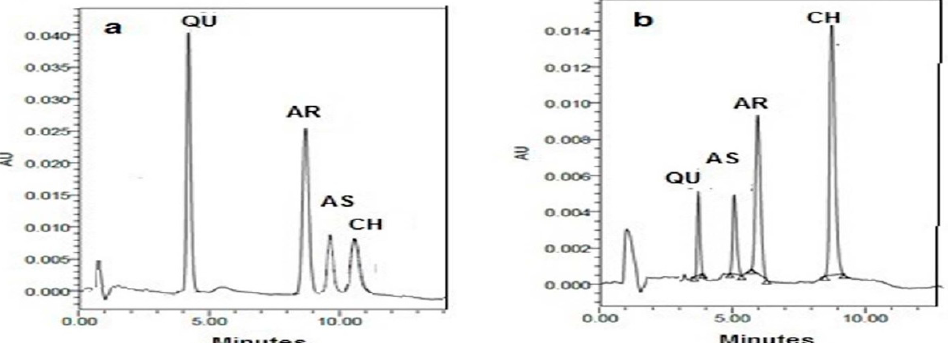
Figure 1. ( a ) HPLC chromatogram of 20 µ L injection of synthetic mixture having 10.0 µ g mL − 1 of QU, 7.0 µ g mL − 1 of AR, 10.0 µ g mL − 1 of AS, and 10.0 µ g mL − 1 of CH using the green HPLC